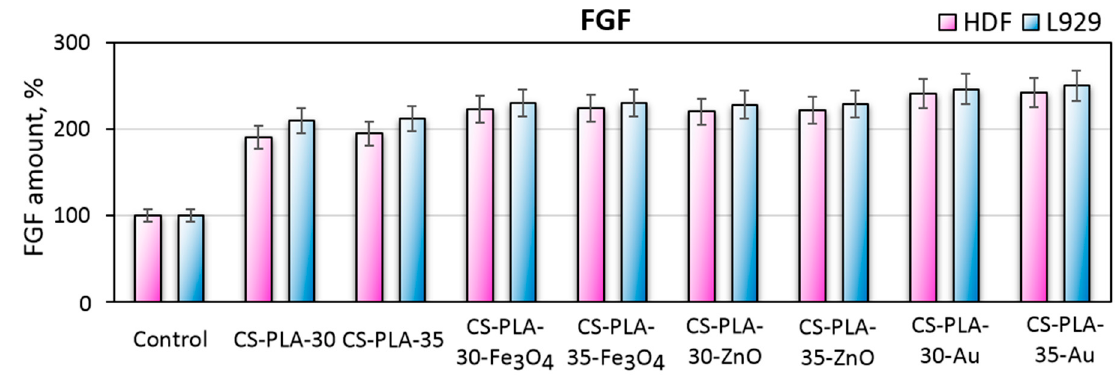
Figure 14. Basic Fibroblast Growth Factor secreted by L929 fibroblasts and human dermal fibroblasts.